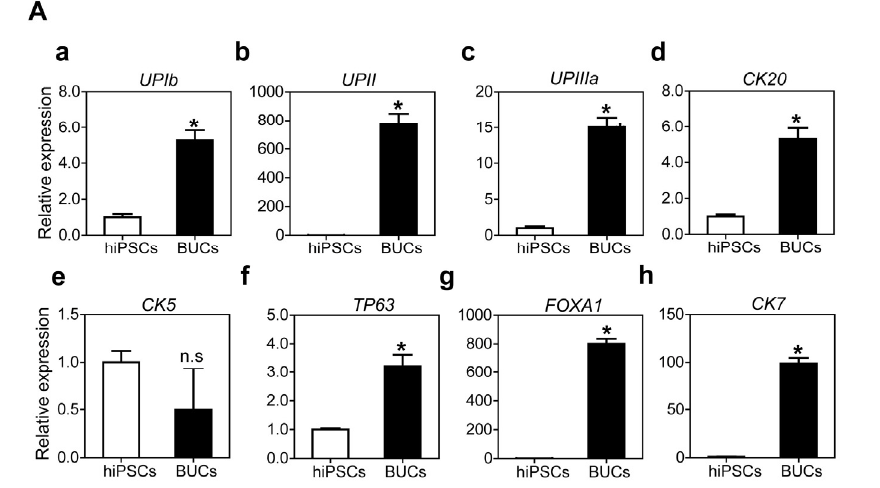
Figure 5. Specification of BUCs from hiPSC-derived DE cells. ( A ) Comparison of transcriptional expression of urothelial marker genes ( a , UPIb ; b , UPII ; c , UPIIIa ; d , CK20 ; e , CK5 ; f , TP63 ; g , FOXA1 ; h , CK7 ) between undifferentiated hiPSCs and hiPSC-derived urothelium. Relative gene expressions were normalized to GAPDH , and fold changes were shown as mean ± SEM ( n = 3; * p < 0.05); ( B ) Comparison of transcriptional expression levels of ( a ) UPII and ( b ) CK7 at various concentrations of RA (0.1 to 20 μ M). Untreated sample was a negative control. Expression levels of transcripts were normalized to GAPDH , and fold changes were shown as mean ± SEM ( n = 3; * p < 0.05); ( C ) Immunocytochemistry for the expression of the key urothelial markers in hiPSC-derived BUCs. Expression patterns of ( a ) UPII (green); ( b ) CK8/18 (red) and ( c ) both these markers; ( d – f ) Evaluation of superficial and basal urothelial markers expression: ( d ) superficial urothleium marker UPII (green, yellow arrow head), ( e ) basal urothelium marker P63 (red, white arrow head), and ( f ) both these markers. Scale bar = 100 μ m; ( D ) Immunocytochemistry for the expression of gap junction molecules E-cadherin (green) and ZO-1 (red) in ( a – c ) DE cells and ( d – f ) BUCs. SOX17 (white) is shown as DE marker. White dashed lines indicate the regions of gap junction molecules-expressing BUCs; Scale bar = 100 μ m; ( E ) In vitro permeability testing of hiPSC-derived DE and BUCs. ( a ) Monolayer staining and ( b ) FITC-dextran permeability analysis. Fluorescence intensities were quantified (one second counting time) and shown as mean ± SEM ( n = 3, ** p < 0.01, *** p < 0.001). The no monolayer sample is a negative control. Scale bar = 200 μ m; ( F ) Transcriptional expression of ( a ) a pluripotency gene ( OCT4 ); ( b ) smooth muscle marker genes ( CALPONIN and MYF5 ); ( c ) an intestine maker gene ( FABP2 ); and ( d ) liver marker genes ( AFP and ALB ) were evaluated in hiPSC-derived BUCs by q-PCR. Relative expression values were normalized to GAPDH , and fold-changes were shown by mean ± SEM ( n = 3, * p <